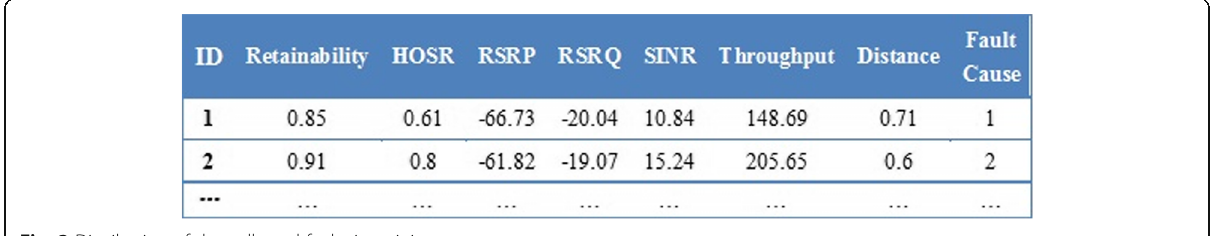
Fig. 3 Distribution of the collected faults in training